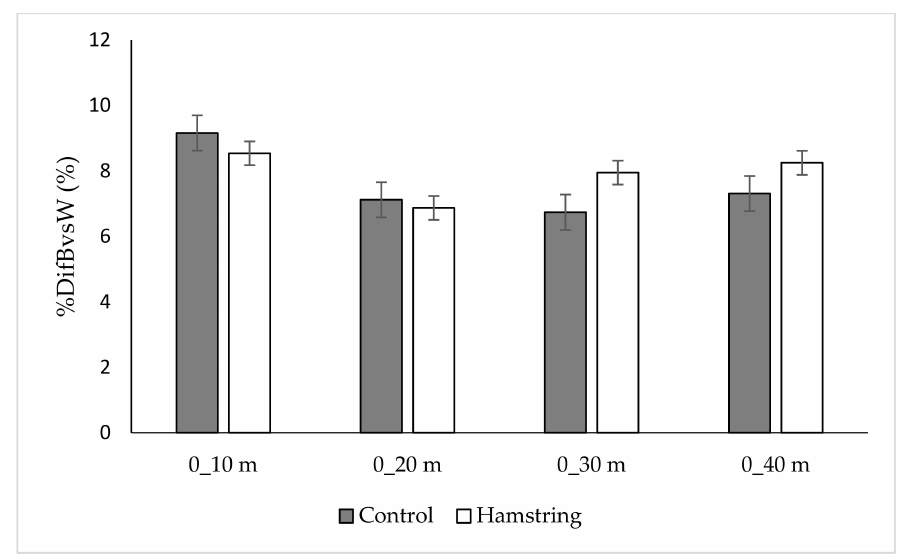
Figure 4. Percentage difference between the best time compared to the worst time to run a split (%DifBvsW) through RSA. Control: Subjects without previous hamstring injury; Hamstring: Subject with previous hamstring